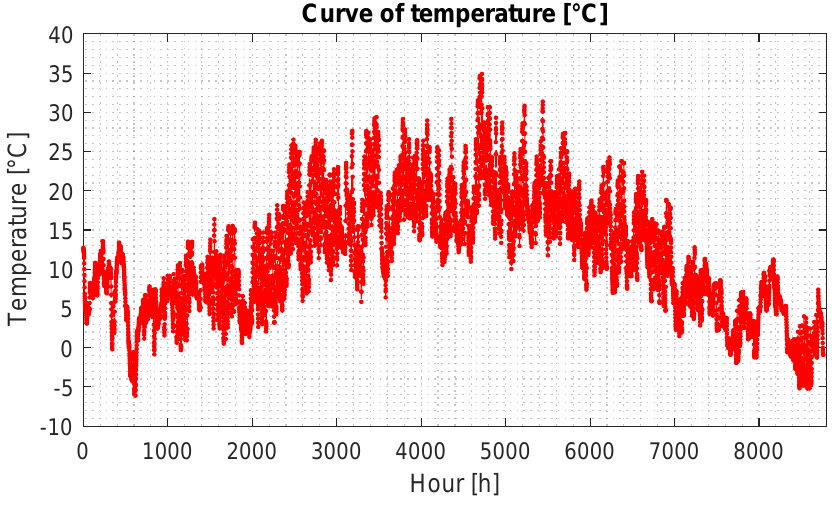
Figure 12. Temperature profile.